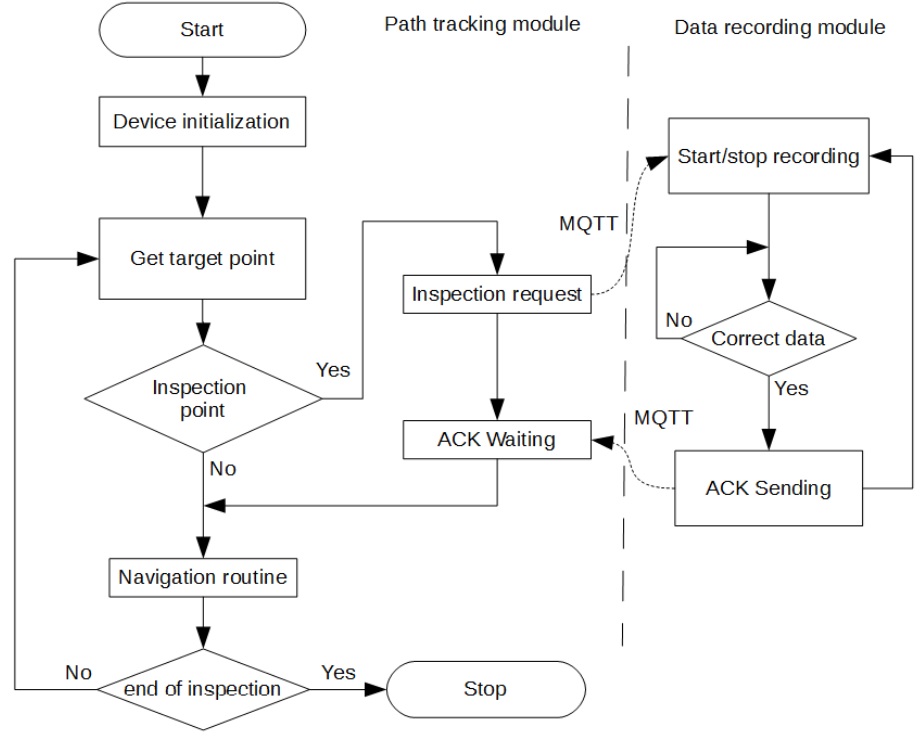
Figure 11. Inspection algorithm and data